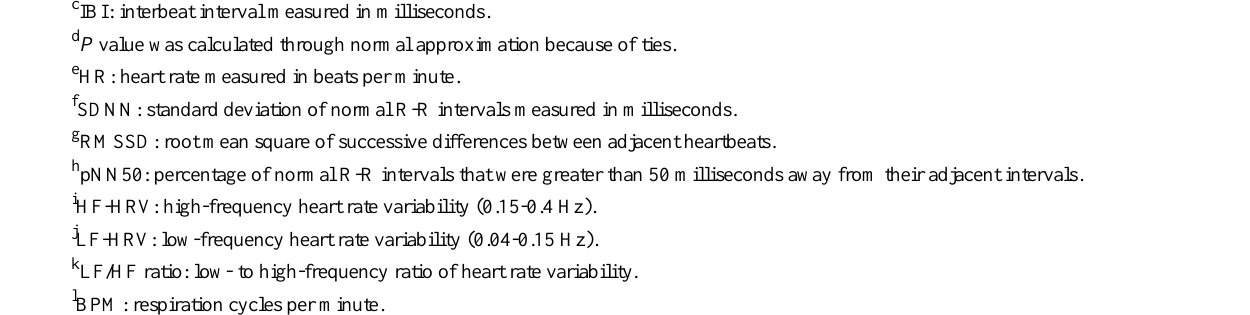
c IBI: interbeat interval measured in milliseconds. d P value was calculated through normal approximation because of ties. e HR: heart rate measured in beats per minute.